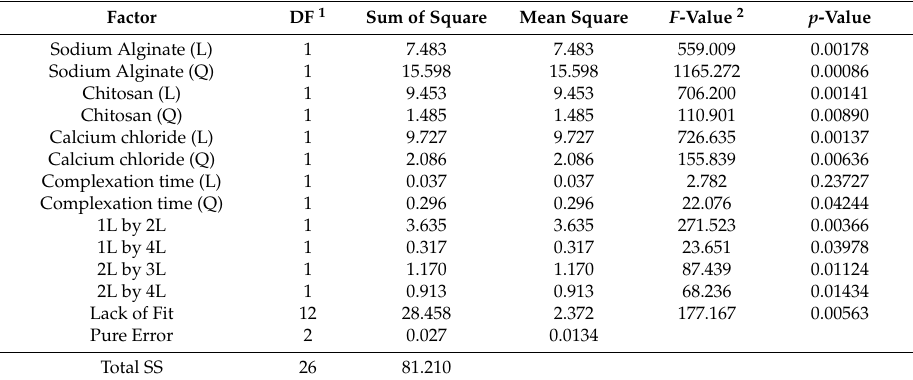
Table 3. Analysis of variance (ANOVA) for central composite rotatable design (CCRD) for immobilization yield. Factor DF 1 Sum of Square Mean Square F -Value 2 p -Value Sodium Alginate (L) 1 7.483 7.483 559.009 2L by 3L 1